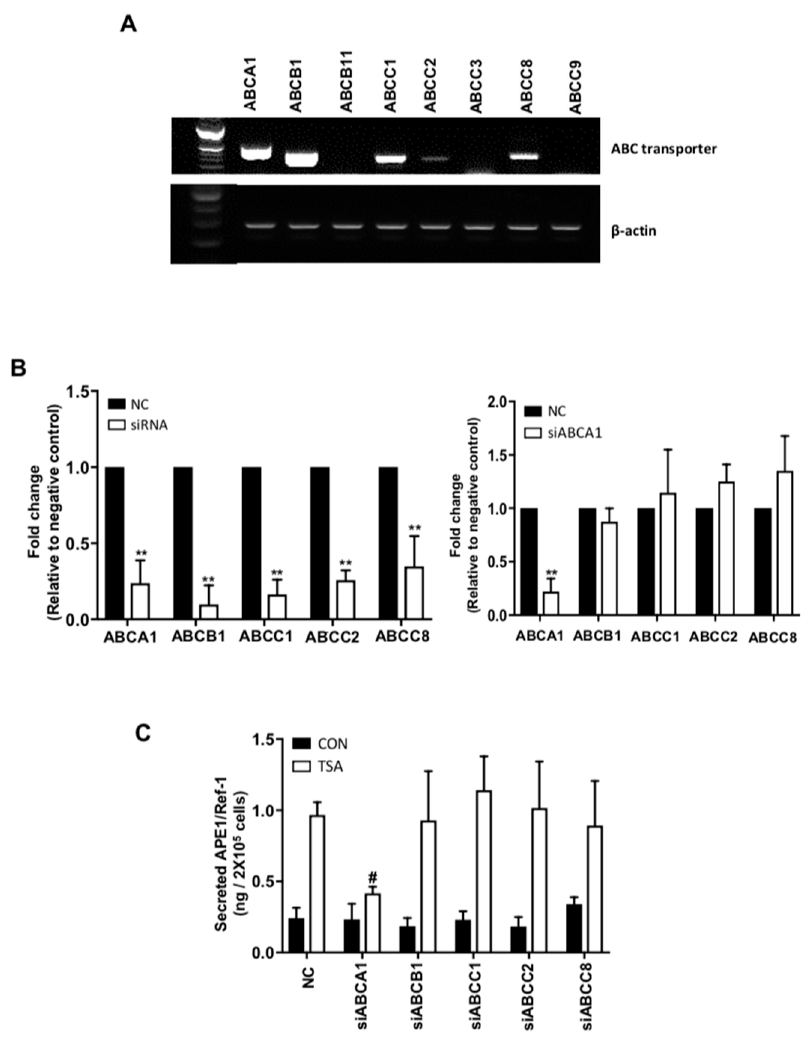
Figure 3. ATP binding cassette transporter A1 (ABCA1) was involved in the secretion of APE1 / Ref-1. ( A ) The subfamily of ABC transporter expressed in HEK293T cells. The qRT-PCR analysis for ABC transporters using lysates from HEK293T cells. β -actin was tested in parallel and normalized an equal amounts of total RNA per sample. ( B ) The subfamily of ABC transporter expressed in HEK293T cells transiently transfected with siRNA. (Left) The qRT-PCR analysis for knock-down of ABC transporters in transfected cells with each siRNA. (Right) mRNA level of each ABC transporters were analyzed using qRT-PCR in siABCA1 transfected cells. Columns , mean ( n = 3); bars , SE. ** p < 0.01 indicated a significantly di ff erent result from non-specific siRNA (NC) transfected cells by two-way ANOVA followed by Bonferroni’s multiple comparison test. ( C ) Changes in the total amount of secreted Ac-APE1 / Ref-1 from cells after knock-down of each ABC transporter were analyzed using ELISA. Columns , mean ( n = 3); bars , SE. # p < 0.05 indicated a significantly di ff erent result from TSA treated cells or between groups by two-way ANOVA followed by Bonferroni’s multiple comparison test.